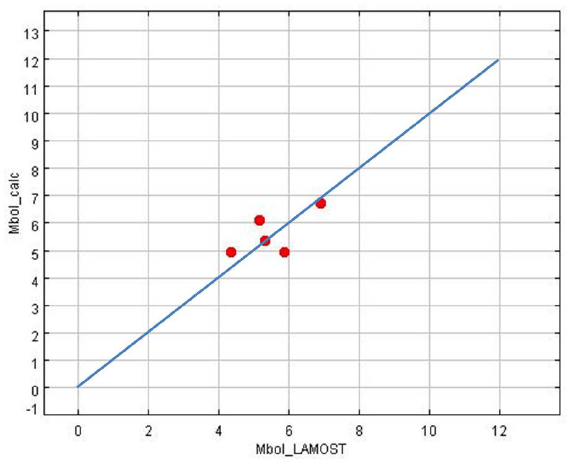
Fig. 5. Comparison of our results with LAMOST data. Errors are about 0.1 and 0.3 mag on X- and Y-axes, respectively. Axes range corresponds to SpT range (B8V-L0V) used in calibration tables (see Section 3.2). Note that LAMOST uses a smaller scale SpT grid than one, used in our calibration tables. Left bottom point represents two